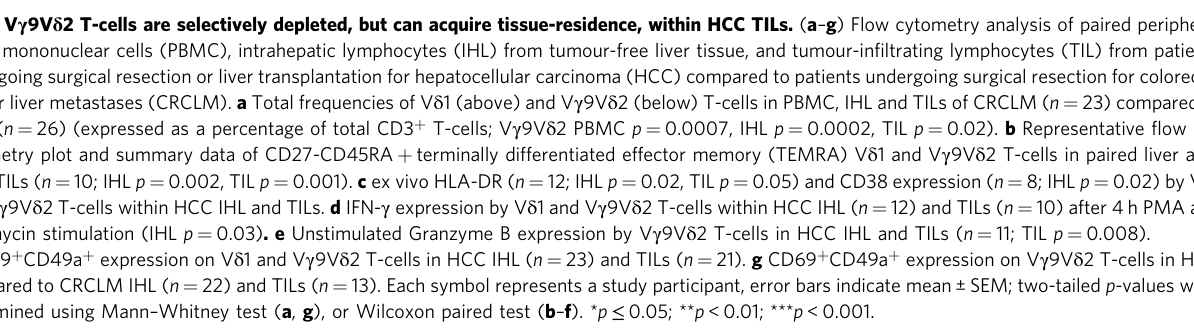
Fig. 5 V γ 9V δ 2 T-cells are selectively depleted, but can acquire tissue-residence, within HCC TILs. ( a – g ) Flow cytometry analysis of paired peripheral blood mononuclear cells (PBMC), intrahepatic lymphocytes (IHL) from tumour-free liver tissue, and tumour-in fi ltrating lymphocytes (TIL) from patients undergoing surgical resection or liver transplantation for hepatocellular carcinoma (HCC) compared to patients undergoing surgical resection for colorectal cancer liver metastases (CRCLM). a Total frequencies of V δ 1 (above) and V γ 9V δ 2 (below) T-cells in PBMC, IHL and TILs of CRCLM ( n = 23) compared to HCC ( n = 26) (expressed as a percentage of total CD3 + T-cells; V γ 9V δ 2 PBMC p = 0.0007, IHL p = 0.0002, TIL p = 0.02). b Representative fl ow cytometry plot and summary data of CD27-CD45RA + terminally differentiated effector memory (TEMRA) V δ 1 and V γ 9V δ 2 T-cells in paired liver and HCC TILs ( n = 10; IHL p = 0.002, TIL p = 0.001). c ex vivo HLA-DR ( n = 12; IHL p = 0.02, TIL p = 0.05) and CD38 expression ( n = 8; IHL p = 0.02) by V δ 1 and V γ 9V δ 2 T-cells within HCC IHL and TILs. d IFN- γ expression by V δ 1 and V γ 9V δ 2 T-cells within HCC IHL ( n = 12) and TILs ( n = 10) after 4 h PMA and Ionomycin stimulation (IHL p = 0.03) . e Unstimulated Granzyme B expression by V γ 9V δ 2 T-cells in HCC IHL and TILs ( n = 11; TIL p =